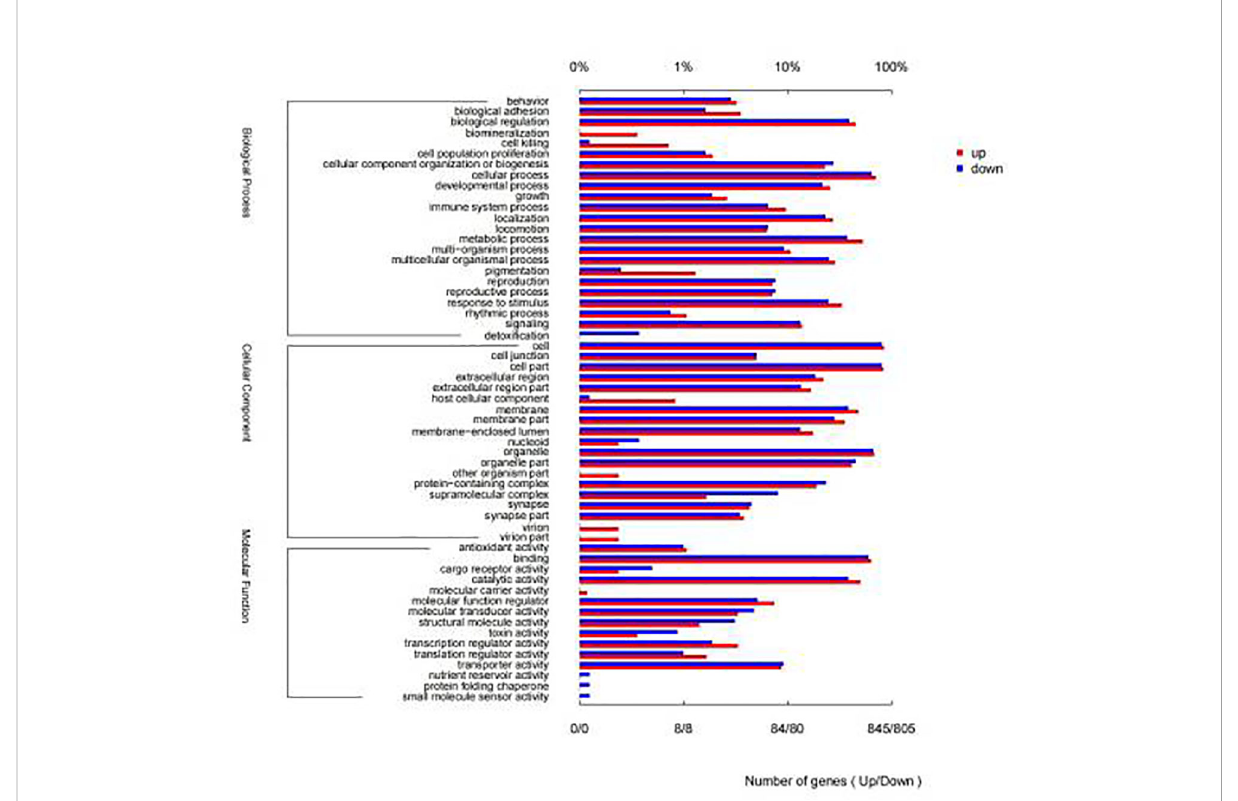
FIGURE 2 Gene ontology classi fi cations of assembled unigenes. A total of 845 unigenes were categorized into 3 functional categories: biological process, cellular component and molecular